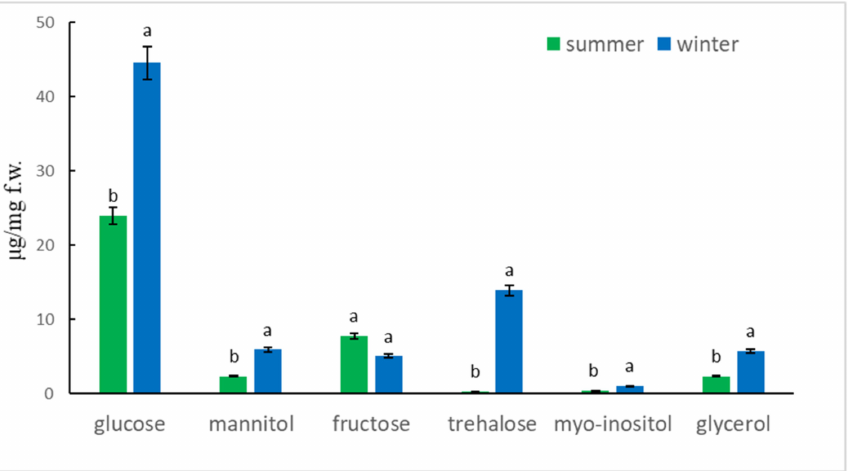
Figure 8. Mean cryoprotectants concentration in the body of C. tujafilina during summer and winter season. Values, marked with different letters, differ significantly at p < 0.05 ( t